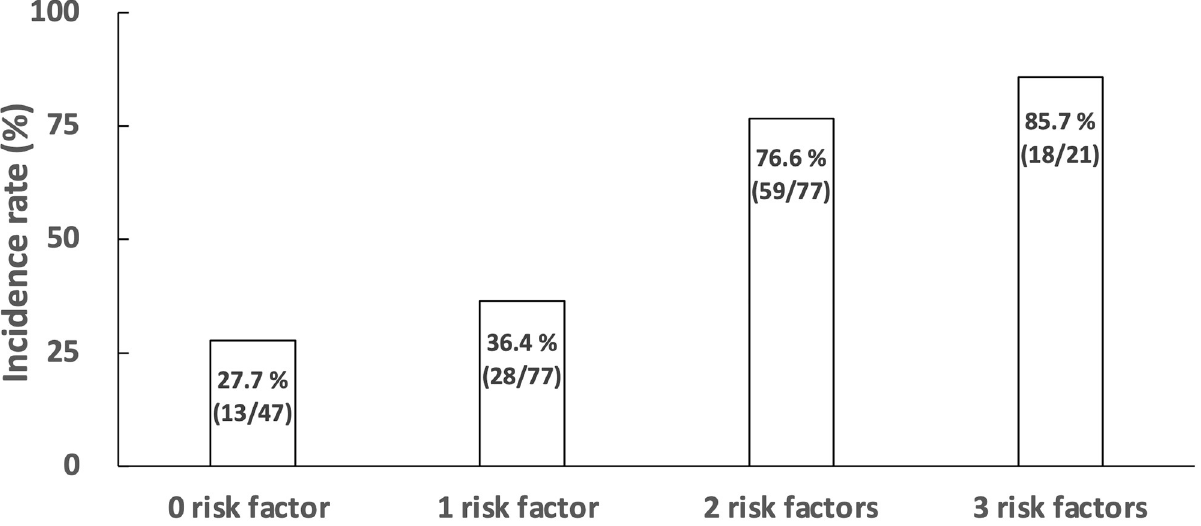
Fig 3. Comparison of incidence rates of neutropenia Grade 3/4 by number of risk factors. Patients were divided according to their number of risk factors (ANC < 3.03 × 10 3 / μ L, T-Bil � 0.6 mg/dL, and CRP < 0.13 mg/dL), and the incidence of neutropenia Grade 3/4 was calculated in each group.